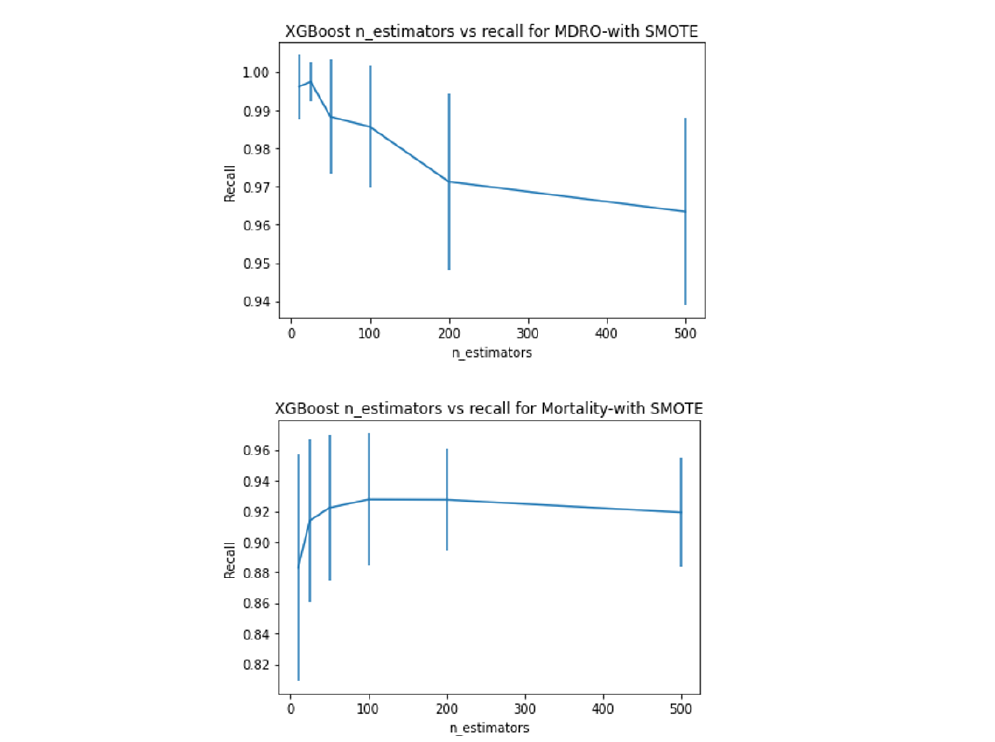
Figure 6. Shows the recall versus number of estimators for all three outcomes with data augmentation on the training set, plotted using XGboost as the base